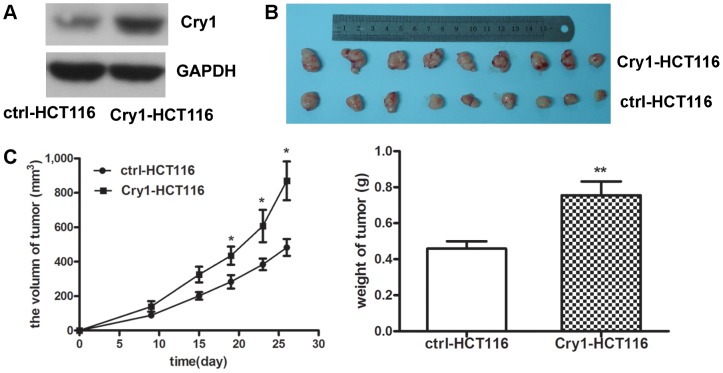
Cry1 promoted CRC growth in vivo.(A) The expression of Cry1 was markedly increased in the stable cell line Cry1-HCT116 compared with control stable cell line ctrl-HCT116. GAPDH was used as an internal control. (B) Representative images of tumors derived from Cry1-HCT116 or ctrl-HCT116,following subcutaneous xenograft transplants in nude mice (C) Overexpression of Cry1 promoted colorectal cancer growth. Tumor cells were injected subcutaneously into nude mice. Mice were sacrificed after 4 weeks, and the volume of each tumor was measured every 4 days. Bars, ±SEM; *P<0.05, ** p = 0.01.